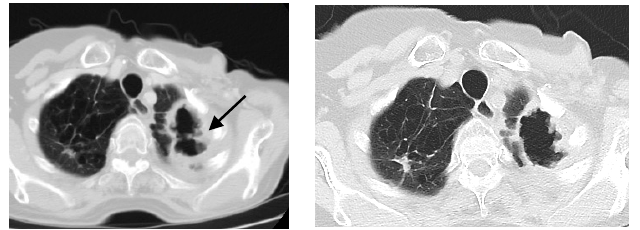
Figure 1. Chest X-ray; ( a ) before treatment—thick-walled cavity in the upper left lobe, multiple nodular opacities in both lungs and patchy consolidation at the base of the right upper lobe; ( b ) after treatment—regression of nodular opacities in both lungs, slight reduction of the cavity in the left upper lobe.